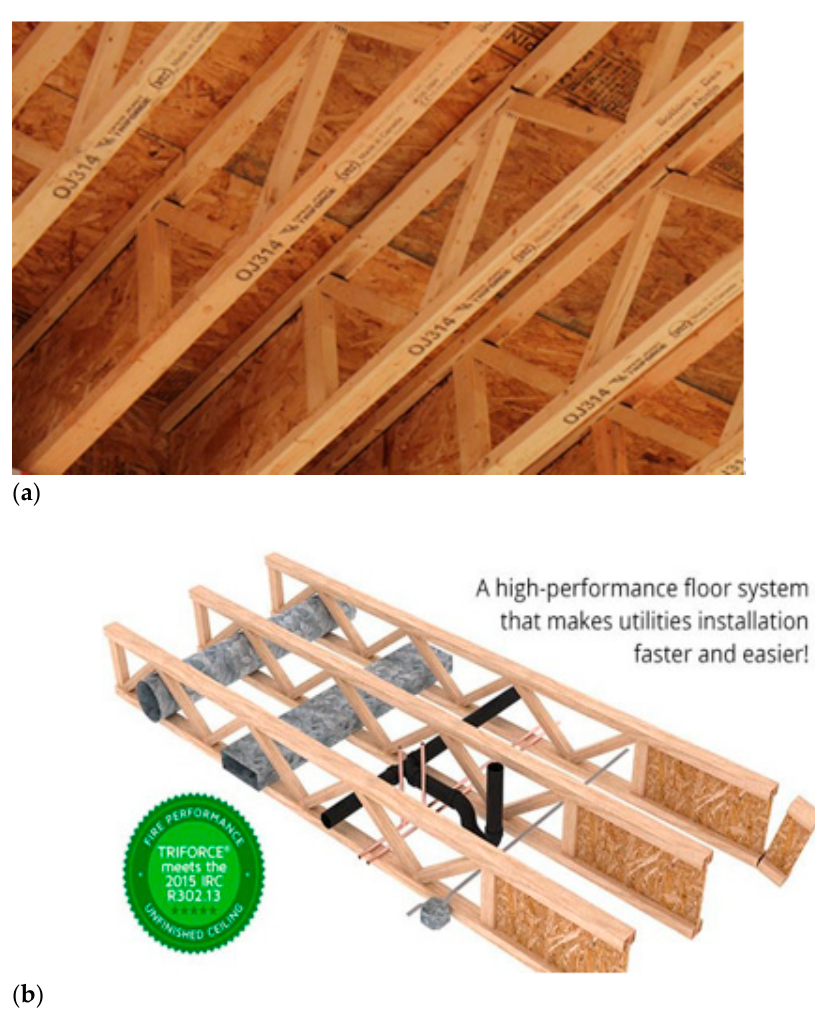
Figure 1. Examples of finger-jointed trusses: ( a ) roof constructions; ( b ) floor structures. [38]